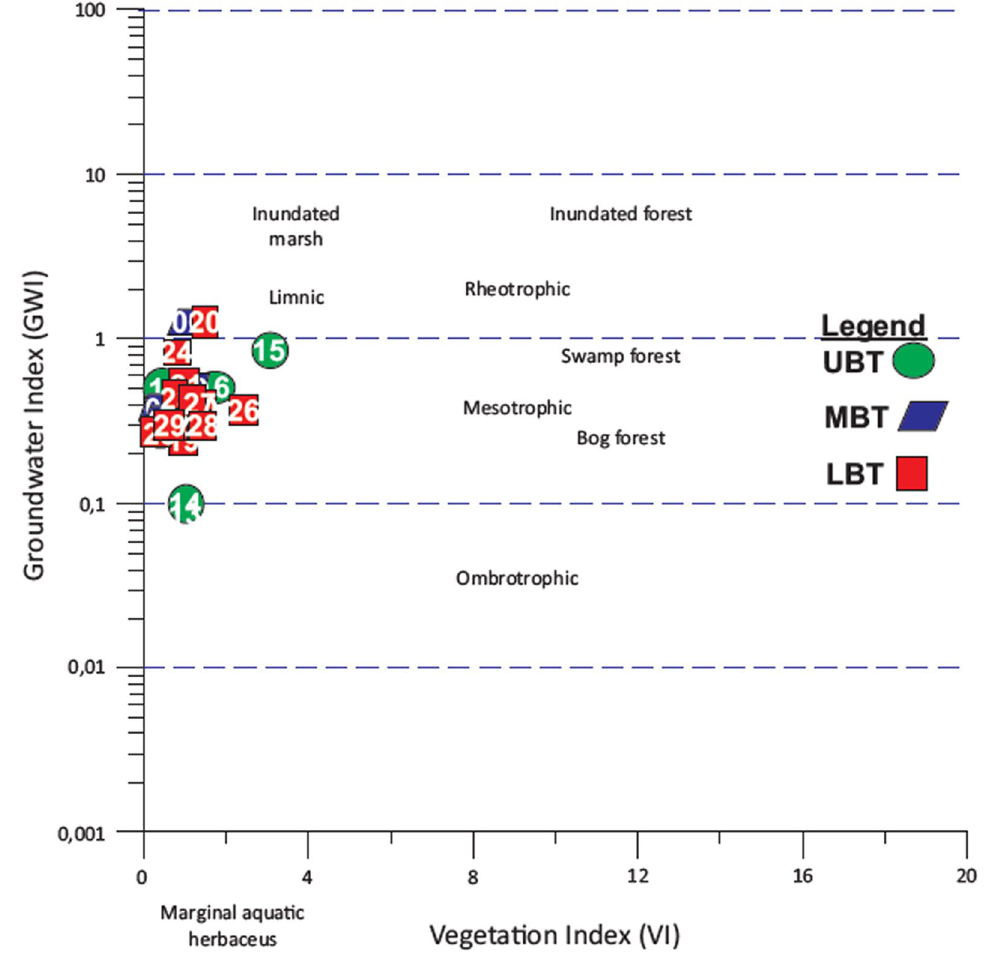
Fig. 9 Coal facies interpretation of the coals within the Benue Trough, Nigeria, based on GWI against VI indices using Eqs. (5), (6), and